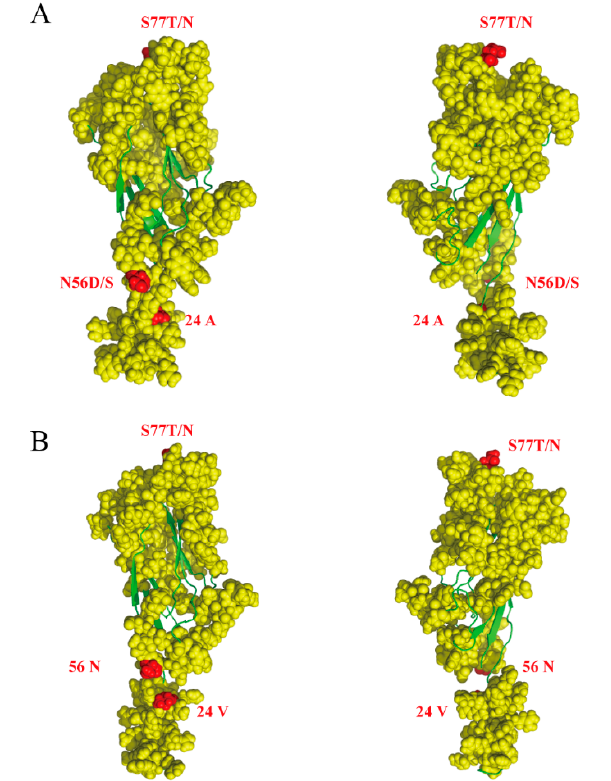
Figure 4. Predicted structure of PCV3 Cap protein. Cap protein structure was predicted using I-TASSER (https: // zhanglab.ccmb.med.umich.edu / I-TASSER / ). The yellow filled circles indicate the epitope of PCV3 cap protein, the red filled circles indicate amino acids subjected to positive selection, and green lines indicate α -helixes and β -folds. ( A ) PCV3a (MF318452:PCV3-BJ-2), ( B ) PCV3b (KX458235:2164).